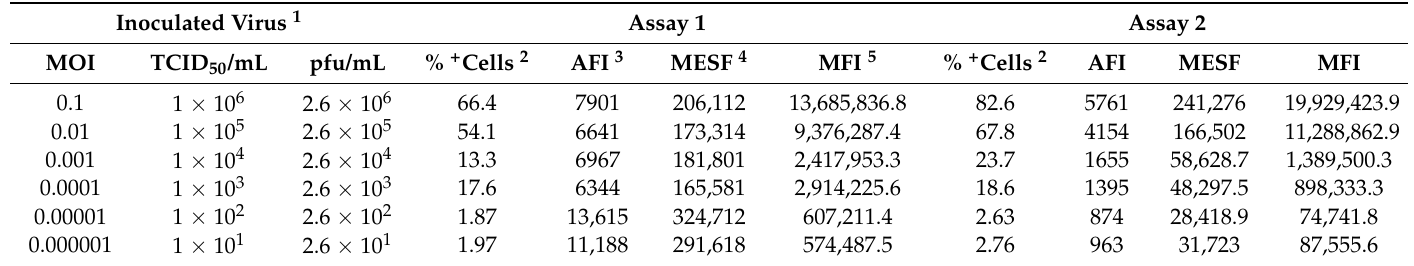
Table 3. Reliability of the qFCM for viral